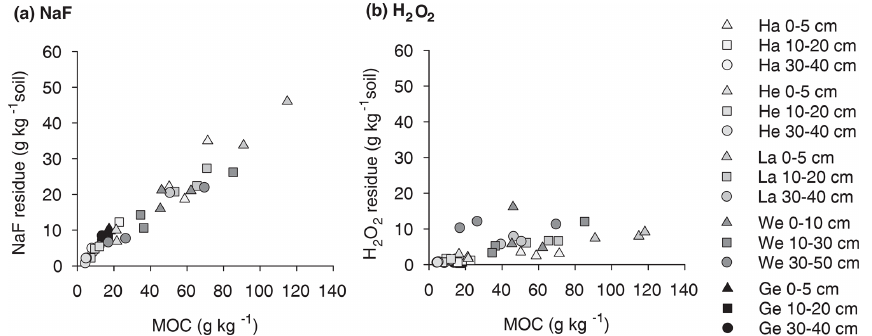
Figure 2. Residual OC depended on original concentrations of mineral-associated OC for (a) NaF–NaOH extraction and (b) H 2 O 2 oxidation for Hainich (Ha), Hesse (He), Laqueuille (La), Wetzstein (We), and Gebesee